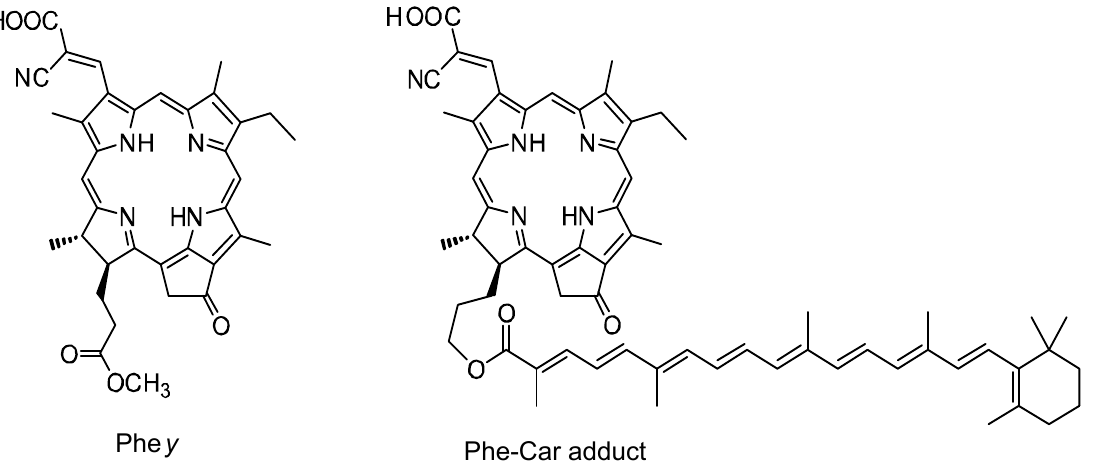
Figure 16. Chemical structures of Phe y and Phe–Car adduct (reprinted from [9] with permission of